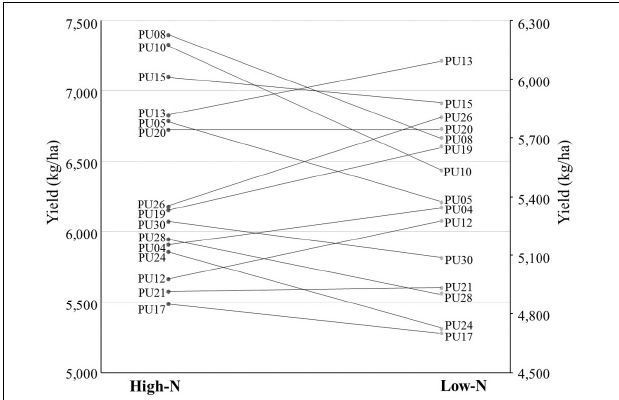
FIGURE 1 | Genotype ranking and interactions based on grain yield (kg ha - 1 ) in low-N and high-N environment for 15 out of 30 genotypes.